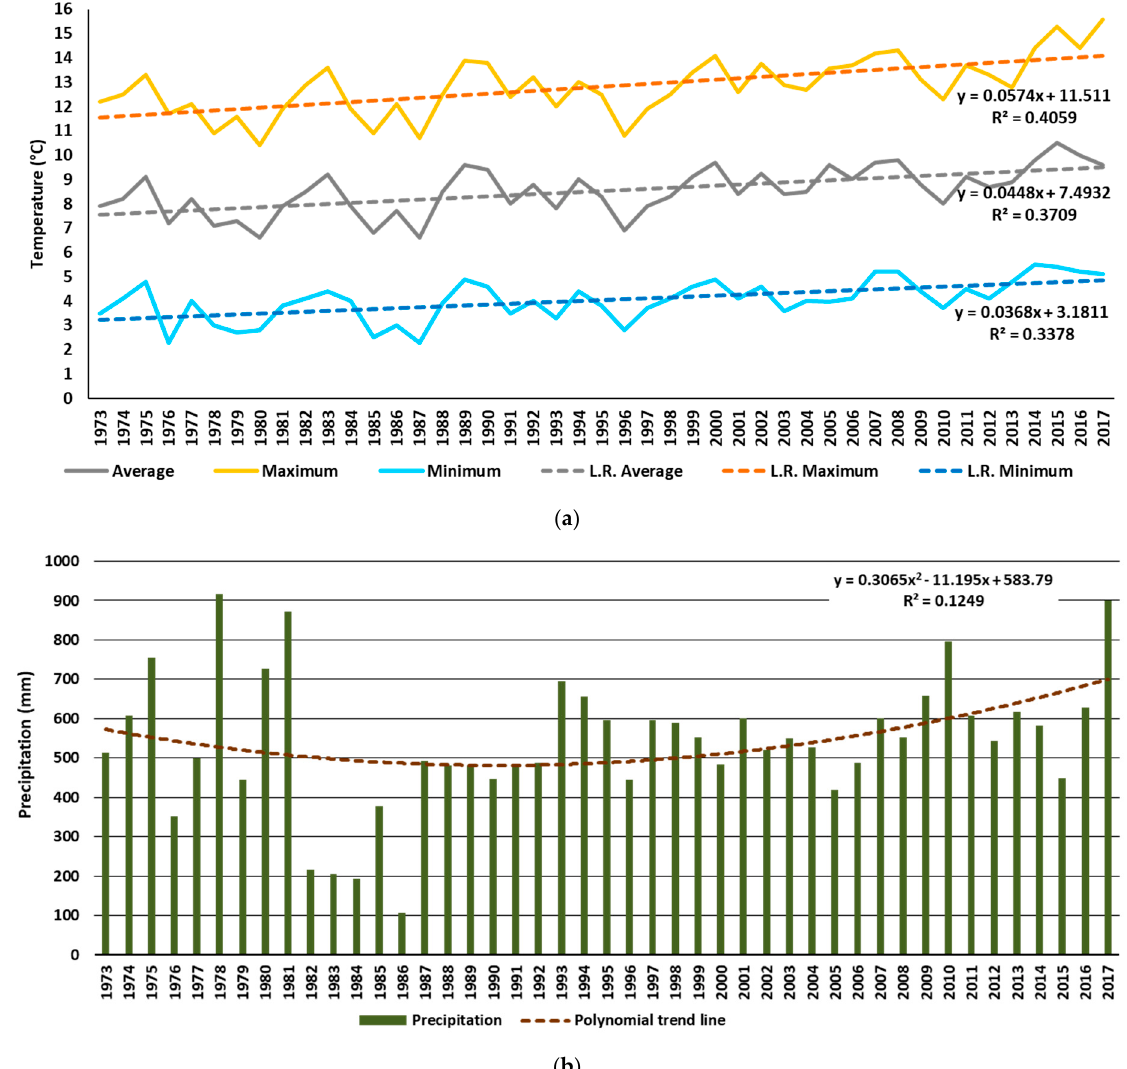
Figure 3. ( a ) The means of monthly temperatures (average, minimal, and maximal) and ( b ) precipitation in the years 1973–2017 noted at the Warsaw-Ok ę cie meteorological station (within 10 km from PAS Botanical Garden) with the ( a ) linear or ( b ) polynomial trend line (adapted with permission from Ref. [45] 2021, MDPI).